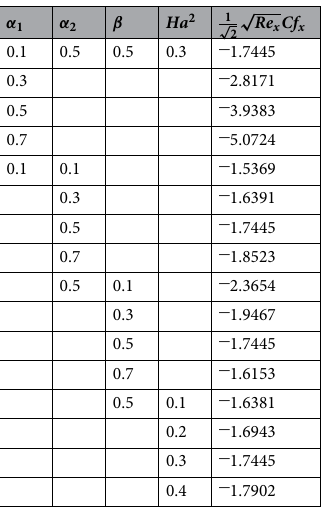
Table 1. Variation of skin friction coefficient with α 1 , α 2 , β , and Ha